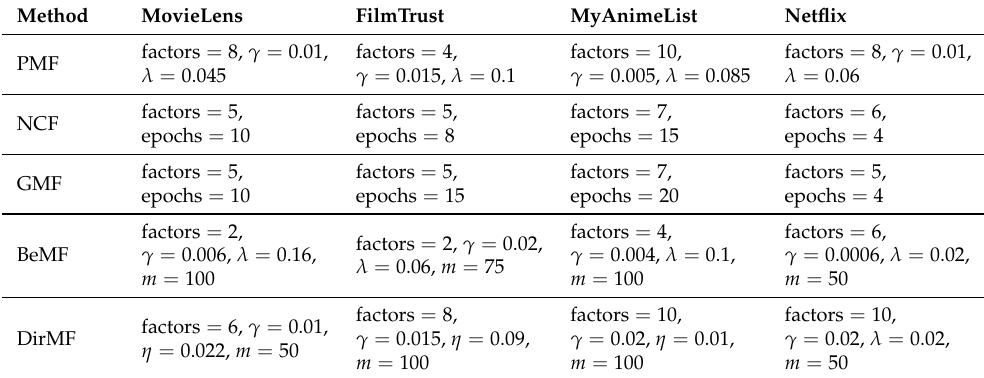
Table 6. Baseline hyperparameters obtained by grid search